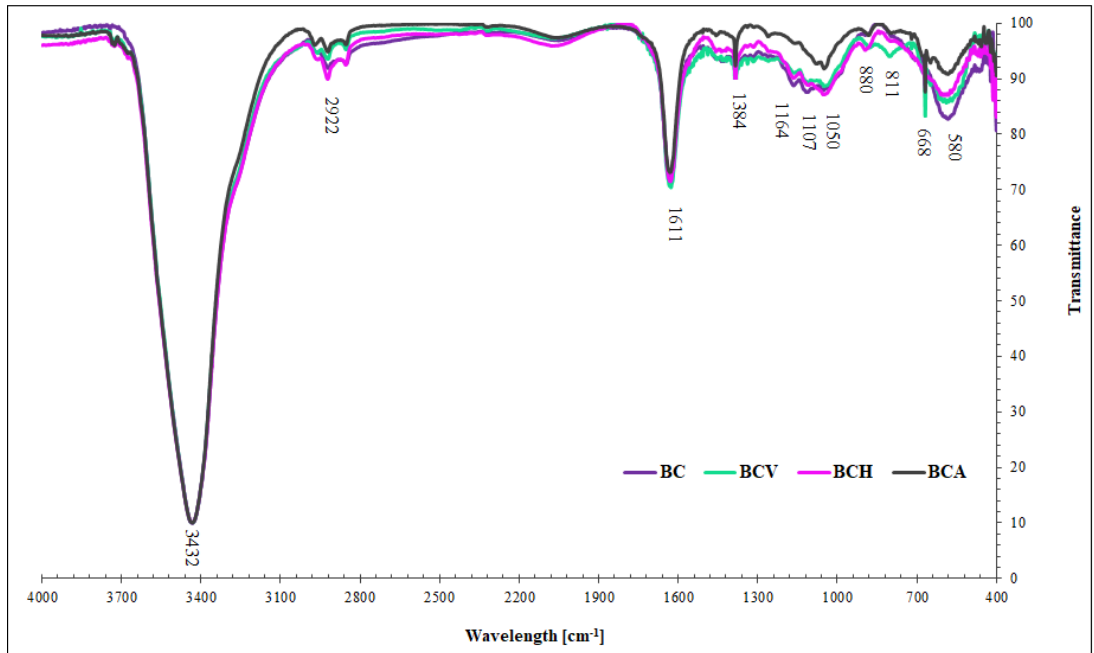
Figure 2. The FTIR spectra of biochars.